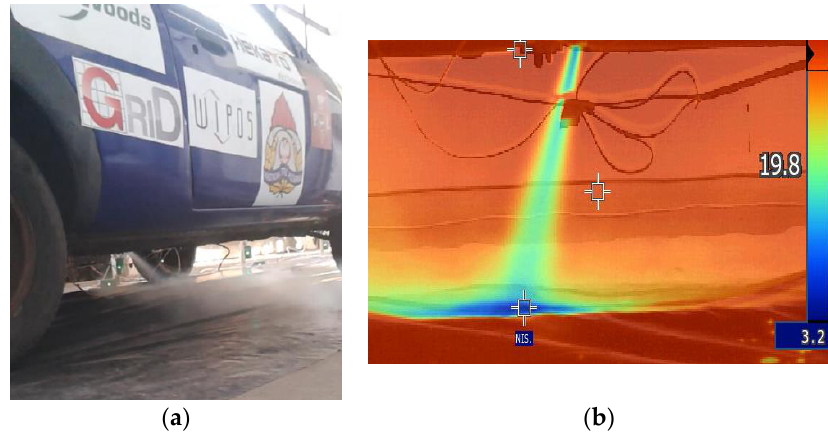
Figure 11. Photos of the LPG emission phenomena: ( a ) LPG gas cloud under the car; ( b ) LPG stream temperature range (an infrared camera photo).